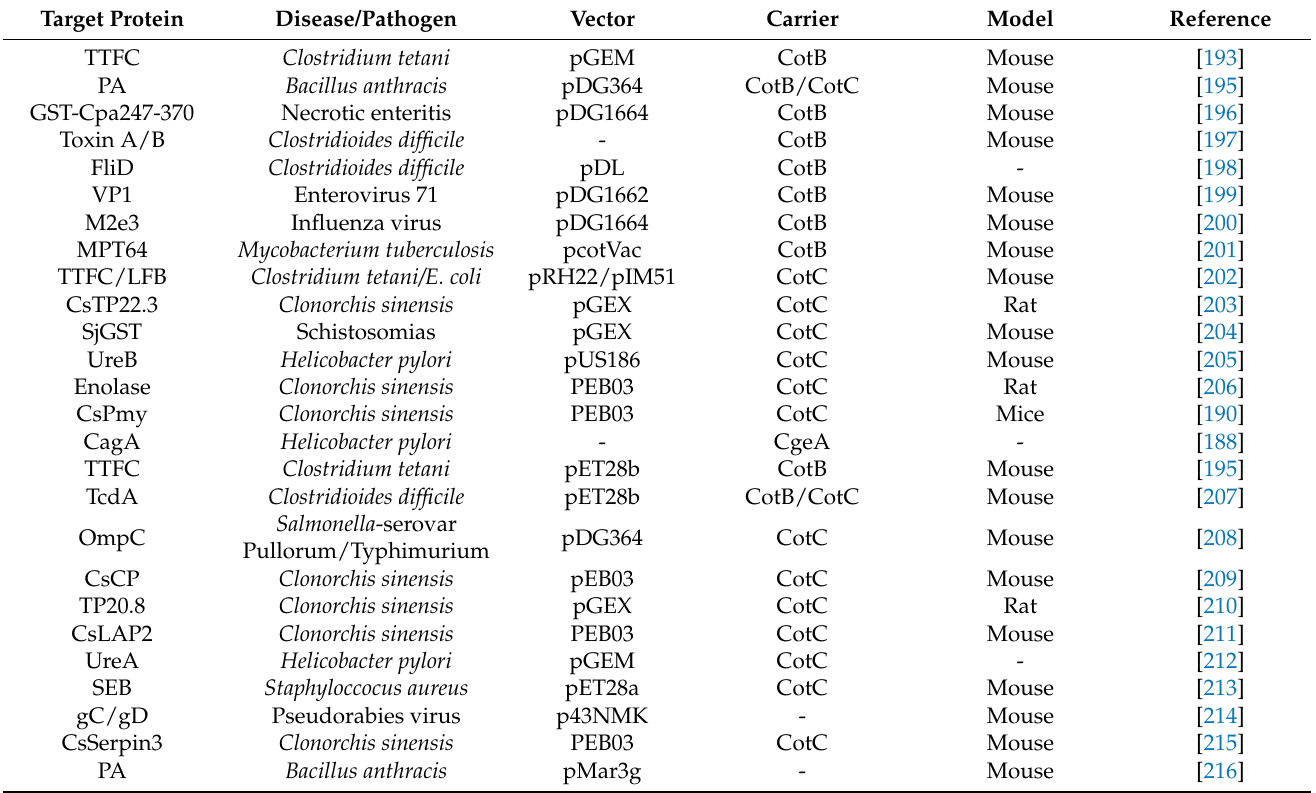
Table 2. An overview of developed vaccine strategies against human pathogens utilizing B. subtilis spores. The target protein, the disease/pathogen it belongs to, the vector used, the carrier protein, and the animal model used to study the effects in are